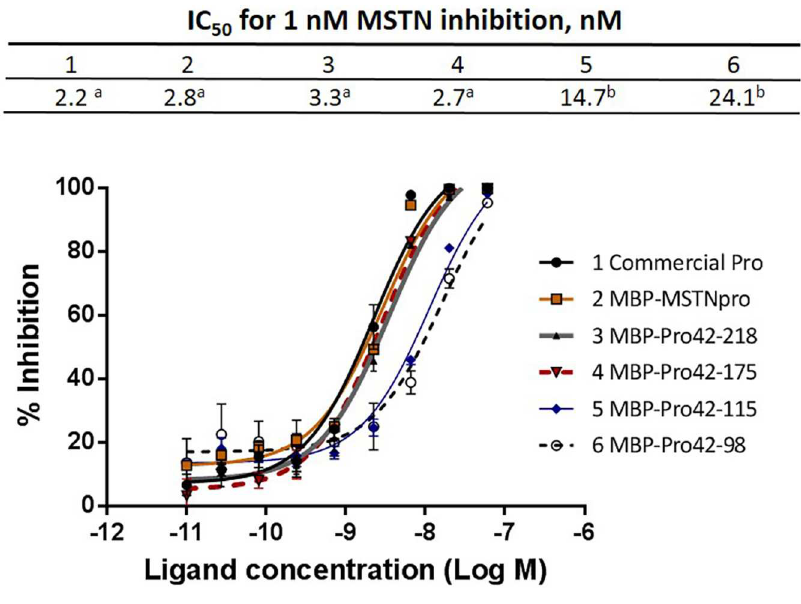
Fig 3. Inhibition of MSTNactivitybyMBP-pMSTNpro proteins. HEK293cellsstablyexpressing(CAGA) 12 - luciferase geneconstructwereseededona 96-wellcultureplateat 40,000cells/well,andgrownfor 24hrinDMEM with10%fetalcalf serum,antibioticandantimycotic. Mediumwasremoved, andMSTN(1nM) andvarious concentrations(60–0nM) of commercialMSTNpro(CommercialPro)orMBP-MSTNproproteinsinDMEMwere addedto eachwell,followedby incubationfor 24hr. Mediumwasremoved,and60 μ Lofluminescence substrate wereaddedandincubated for 3 minutes,followedby luminescence measurement.The% inhibitionof MSTN activitywascalculatedby thefollowingformula:% inhibition= (luminescenceat1 nMMSTN—luminescenceat eachligandconcentration) * 100/(luminescence at 1 nMMSTN—luminescenceat0 nMMSTN). Theerrorbars represent ± SEM(n= 6).The meansof IC 50 not sharingthesamesuperscript aredifferentatP < 0.05.